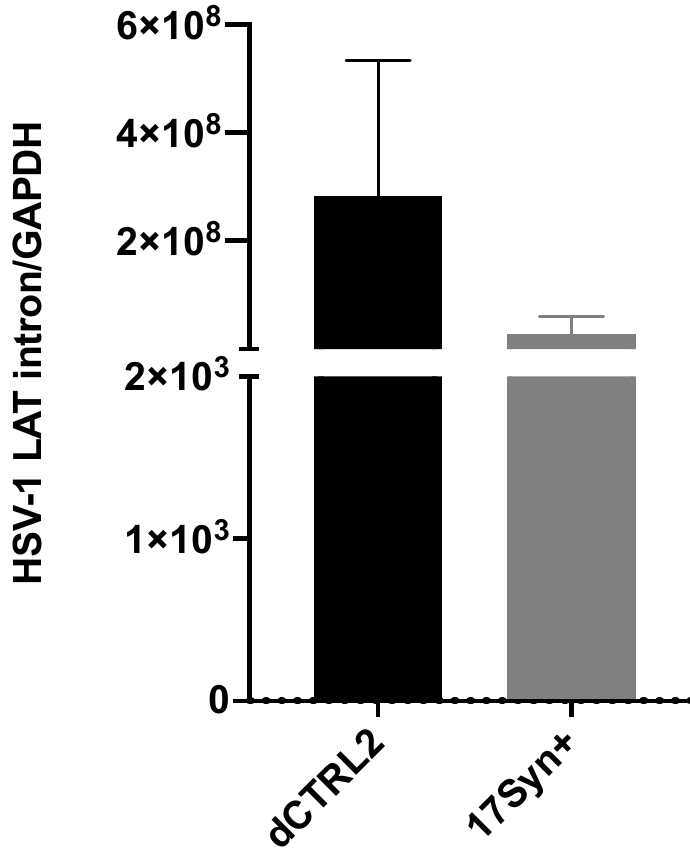
Figure 3. LAT intron expression was significantly higher in the ∆ CTRL2-infected rabbits during latency. Rabbit TG were isolated and RNA extracted, as indicated in the methods section, and subsequently used for qRT-PCR to assess gene expression during latency for the wt and recombinant viruses. Relative values for LAT intron were normalized to rabbit GAPDH and are presented as normalized ratios for gene expression. One-way ANOVA of independent samples was used to determine statistical significance between the mutant and wt ( n = 6). Data presented here are consistent with previous reports in the mouse model [24]. There was a significant increase in LAT intron expression in the ∆ CTRL2-infected rabbits compared to wt-infected animals at